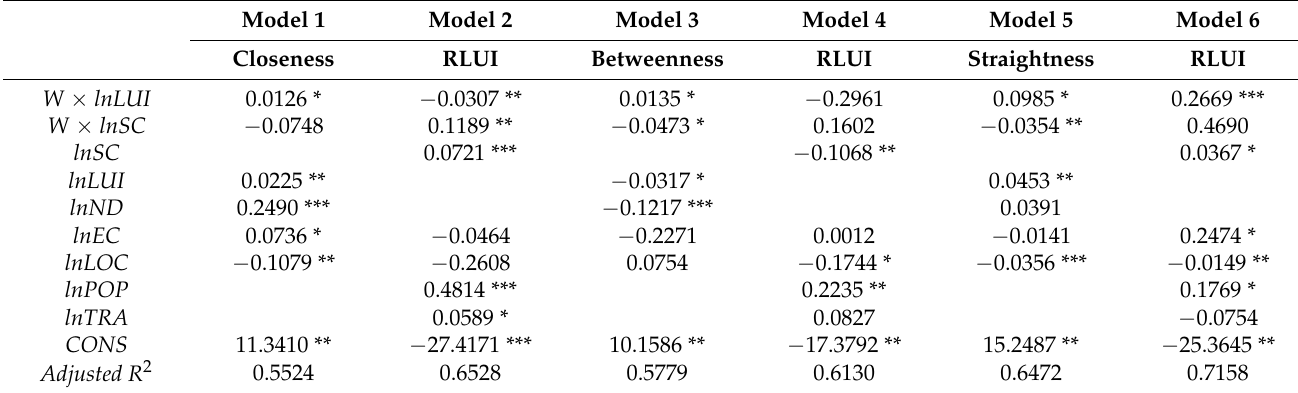
Table 3. Regression results of SC and